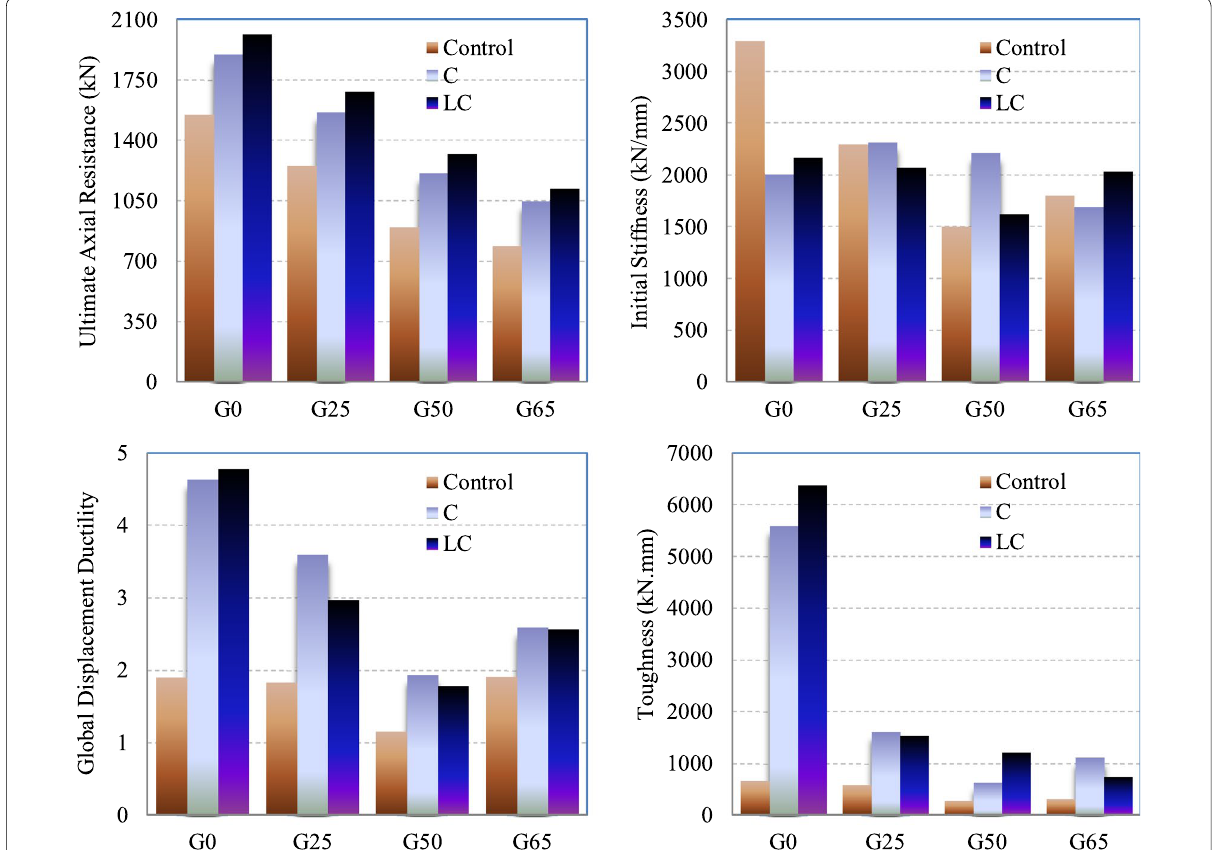
Fig. 6 Effects of loading eccentricity and FRP wrapping system on column